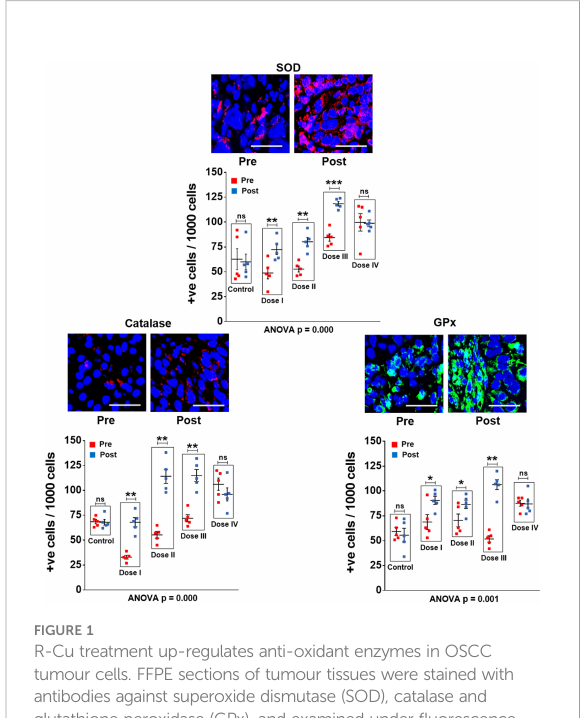
FIGURE 1 R-Cu treatment up-regulates anti-oxidant enzymes in OSCC tumour cells. FFPE sections of tumour tissues were stained with antibodies against superoxide dismutase (SOD), catalase and glutathione peroxidase (GPx), and examined under fl uorescence microscopy. Upper panels provide representative images (scale bar 10µm); lower panels represent quantitative analysis of cells positive for respective anti-oxidant enzymes. One thousand cells were analysed in each case and the number of cells showing positive signals were recorded. Combined statistical comparison of pre versus post treatment values of all four treatment groups with the control group was done using two-way ANOVA; p values of which are given under each graph. Comparison of pre versus post treatment values within each treatment group was performed by paired Student ’ s t-test. Results of the latter are represented as mean ± SEM of 5 patients in each treatment group. *< p < 0.05; **< p < 0.01; ***< p < 0.001; ns, not signi fi